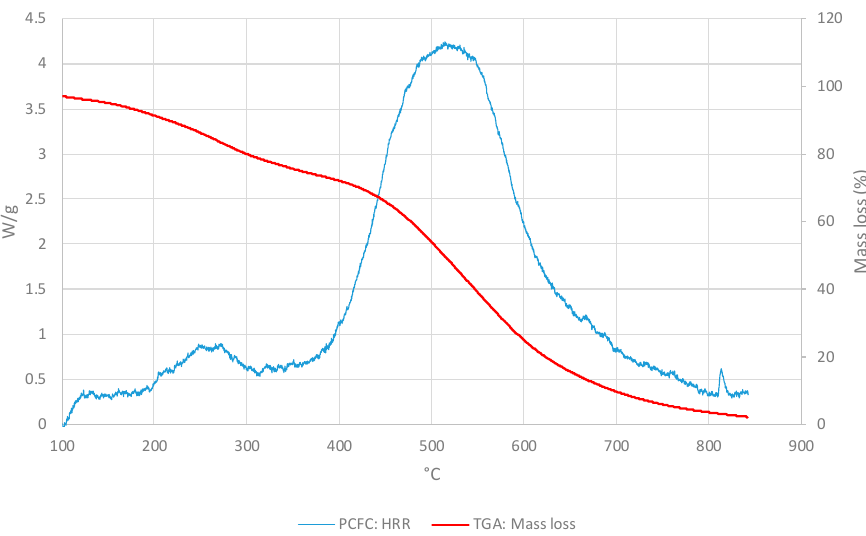
Figure 9. Values for HRRs (W / g) and mass loss (wt.%) for the ONHM layer.